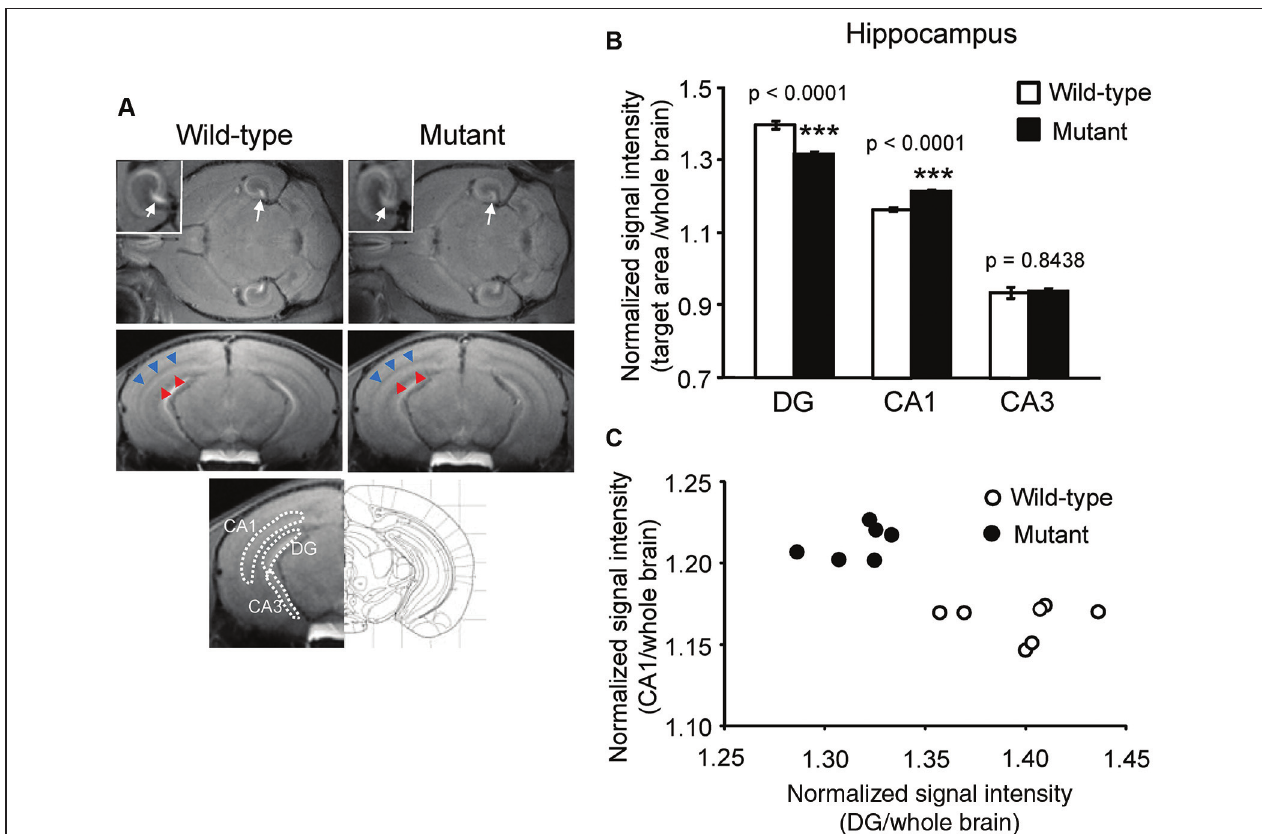
radiatum, including the projection area of the CA3, are indicated by red and blue arrowheads, respectively. The bottom row shows the anatomical location of ROIs in the hippocampus. The ROIs correspond to the DG, CA1, and CA3, respectively. (B) Normalized signal intensities in the hippocampal subregions are presented as the mean ± SEM. The p values indicate genotype effect in one-way ANOVA. (C) Scatterplot of normalized signal intensity in the DG versus CA1